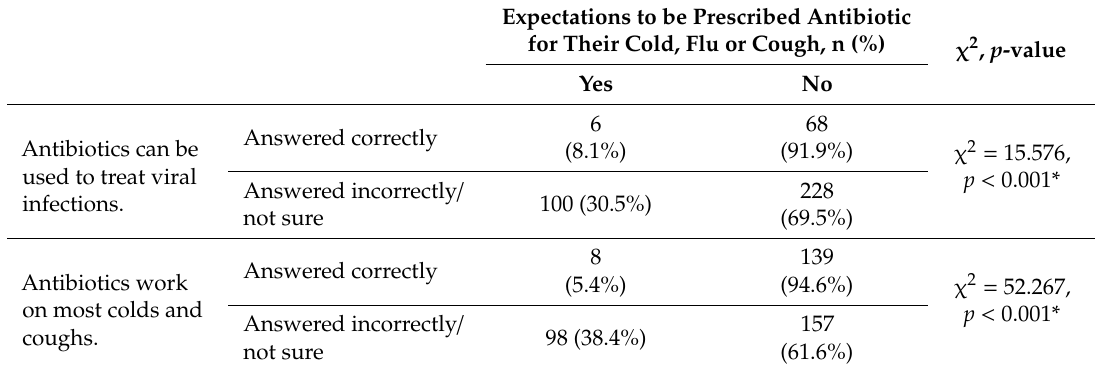
Table 5. Respondents’ knowledge versus their expectations to be prescribed antibiotic for their cold, flu or cough (n =